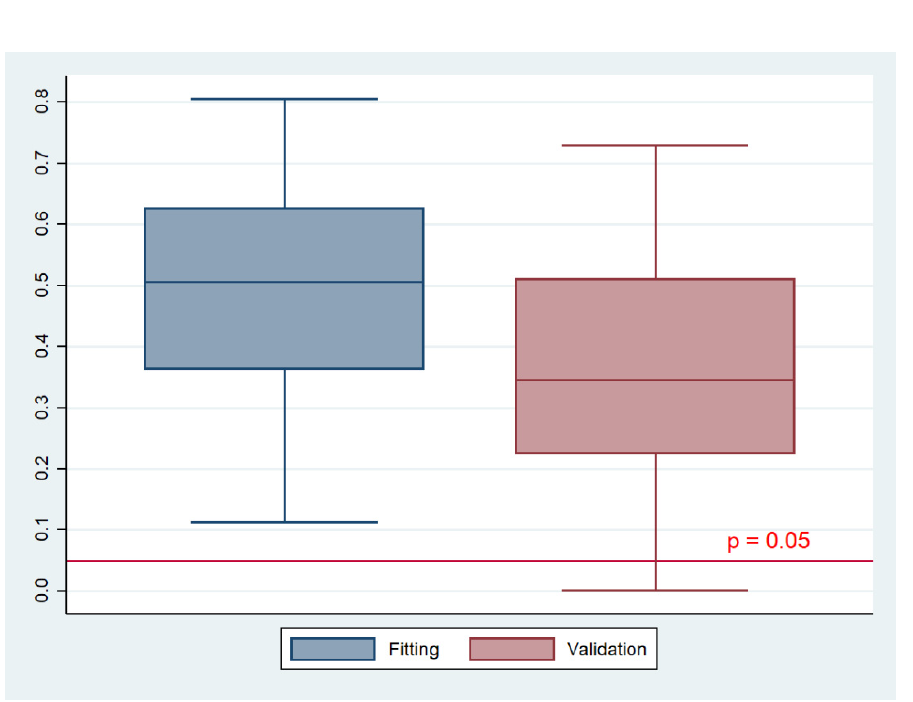
Figure 4. Pearson’s χ 2 — fitting vs. validation model distributions.